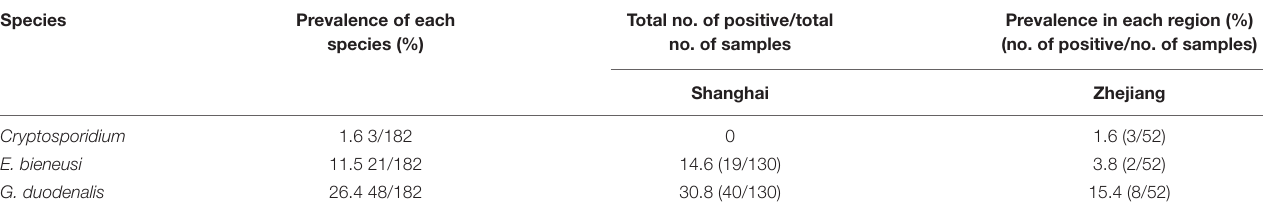
TABLE 2 | Prevalence of Cryptosporidium species, Enterocytozoon bieneusi , and Giardia duodenalis in Shanghai Wild Animal Park and Zhejiang zoo of China. Species Prevalence of each Total no. of positive/total Prevalence in each region (%) species (%) no. of samples (no. of positive/no. of samples)